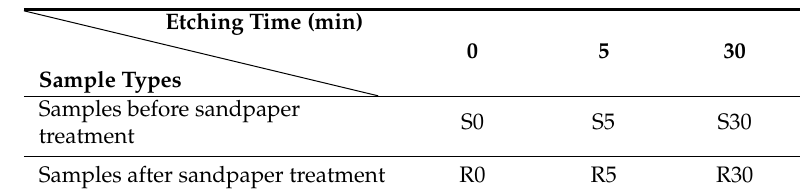
Table 2. Sample number.